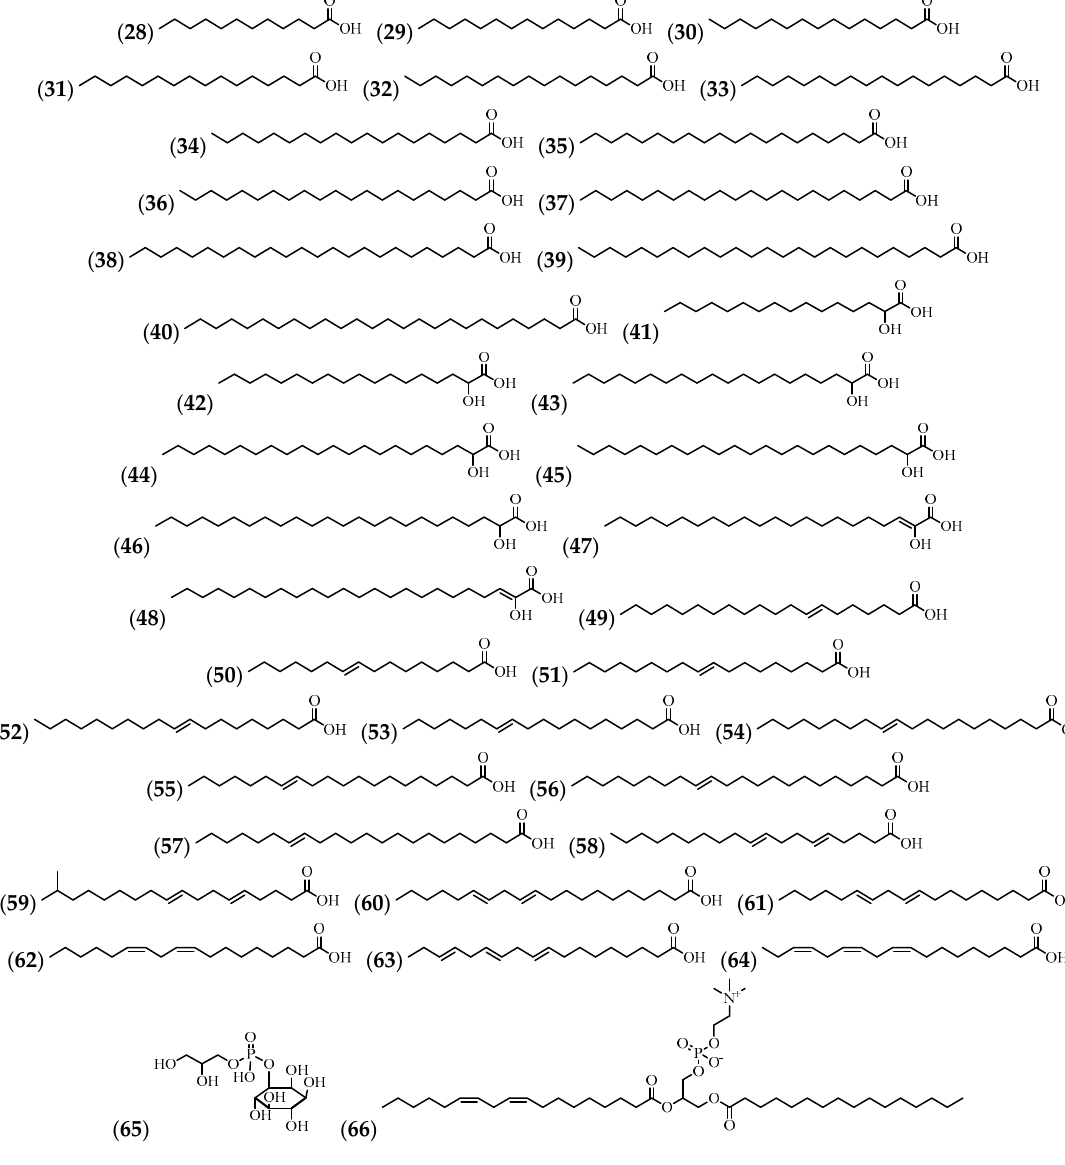
Figure 4. The structures of the fatty acids and phospholipids from A. cathartica.